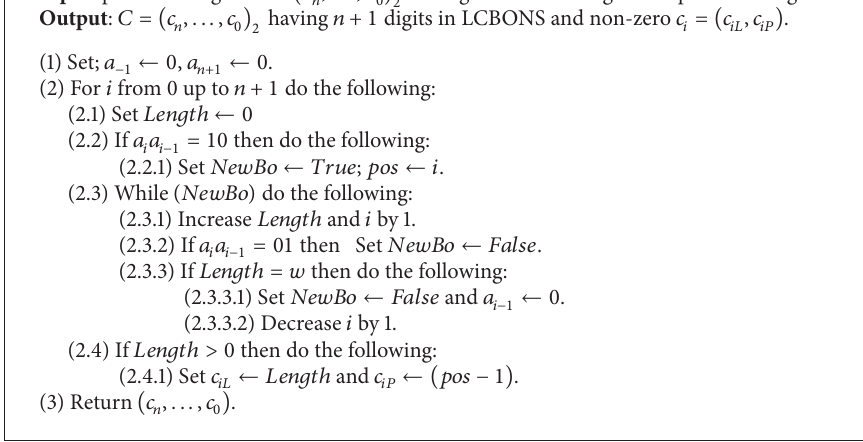
Algorithm 7: Binary to limited Big-one converter algorithm, 𝐵𝑖𝑛2𝐿𝐵𝑂(𝐴) .